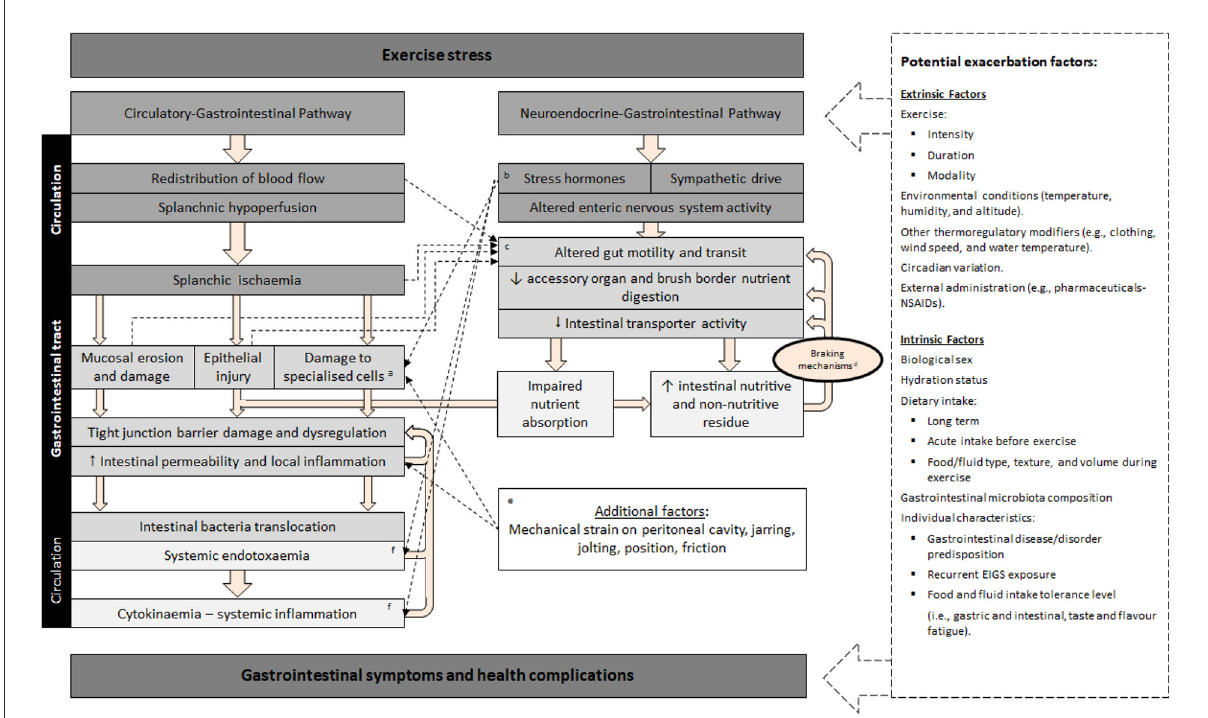
FIGURE1 Schematic description of exercise-induced gastrointestinal syndrome (EIGS): Physiological changes in circulatory and neuroendocrine pathways at the onset of exercise resulting in perturbed gastrointestinal integrity and function, which may lead to gastrointestinal symptoms, with performance and clinical implications (2, 3). a Specialized antimicrobial protein-secreting (i.e., Paneth cells) and mucus-producing (goblet cells) cells, aid in preventing intestinal-originating pathogenic microorganisms entering systemic circulation. b Splanchnic hypoperfusion and subsequent intestinal ischemia and injury (including mucosal erosion) results from stress induced direct (e.g., enteric nervous system, and/or enteroendocrine cell) or indirect (e.g., braking mechanisms) alterations to gastrointestinal motility. c Increase in neuroendocrine activation and suppressed submucosal and myenteric plexus result in epithelial cell loss and subsequent perturbed tight junctions (4, 5). d Gastrointestinal brake mechanisms: Nutritive and non-nutritive residue along the small intestine, and inclusive of terminal ileum, results in neural and enteroendocrine negative feedback to gastric activity (6–10). e Aggressive acute or low grade, prolonged mechanical strain, is proposed to contribute toward disturbances to epithelial integrity (i.e., epithelial cell injury and tight-junction dysregulation) and subsequent “knock-on” effects for gastrointestinal functional responses (11). f Bacteria and bacterial endotoxin microorganism molecular patterns (MAMPs), and stress induced danger associated molecular patterns (DAMPs), are proposed to contribute toward the magnitude of systemic immune responses (e.g., systemic inflammatory profile) (12). Adapted from Costa et al. (2), with